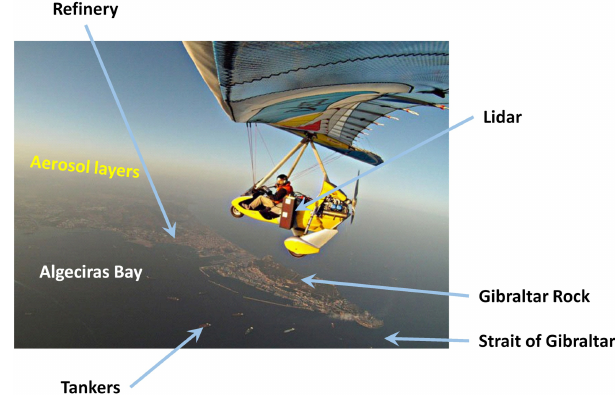
Figure 1. Ultralight aircraft (ULA) above the Strait of Gibraltar. The lidar is located on the left side of the ULA in nadir-shooting position. The aerosol layer can be seen in ochre on the horizon of the